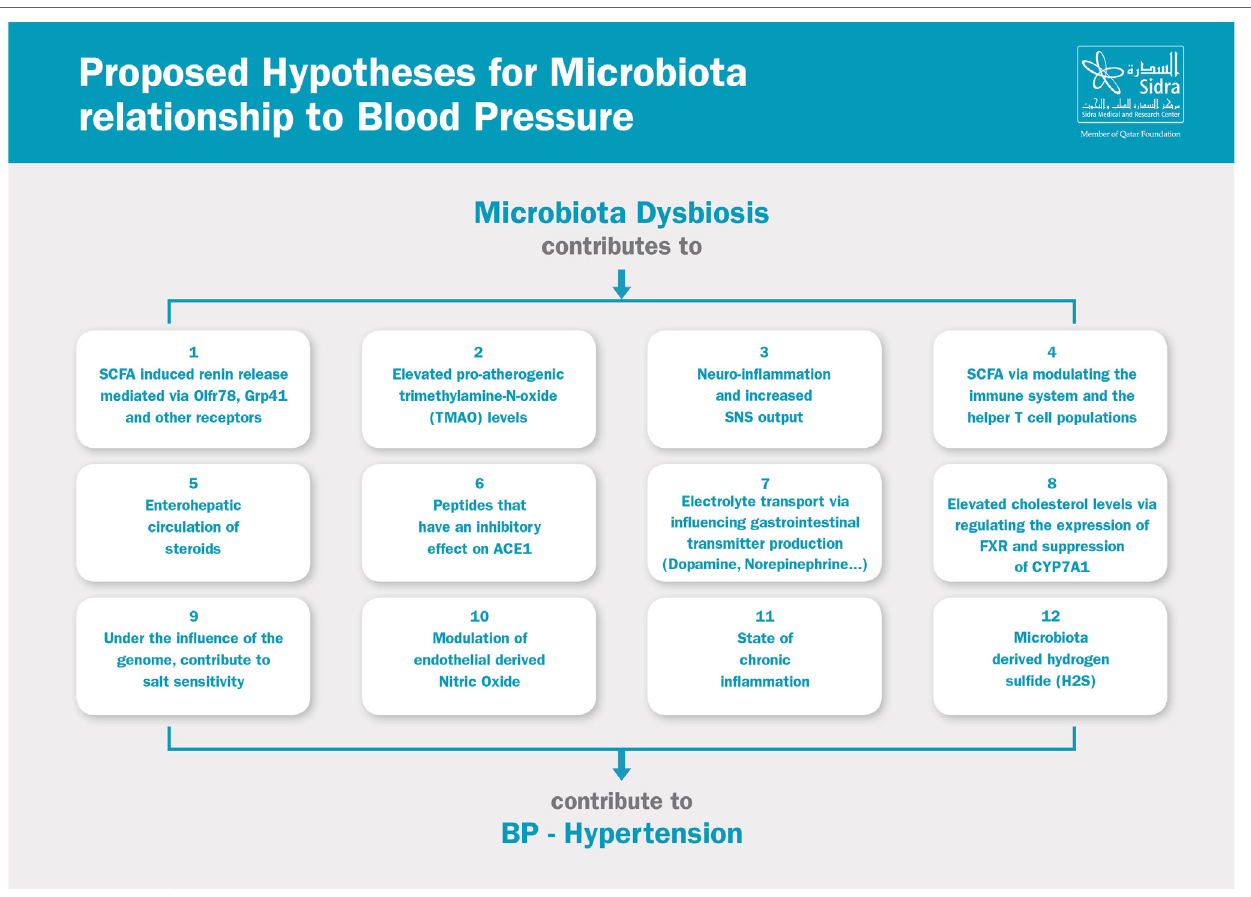
FiGURe 2 | Proposed hypotheses for microbiota relationship to blood pressure. SCFA, short-chain fatty acids; SNS, sympathetic nervous system; ACE, angiotensin-converting enzyme; FXR, farnesoid X